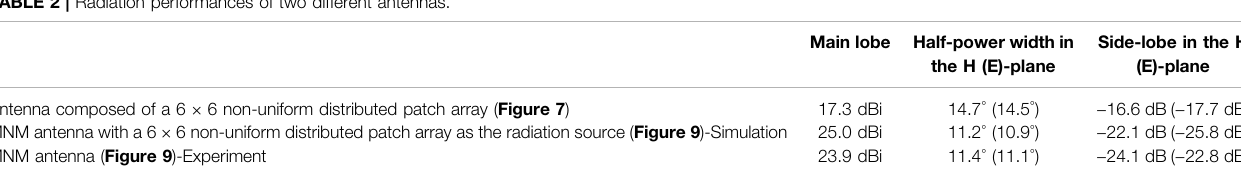
TABLE 2 | Radiation performances of two different